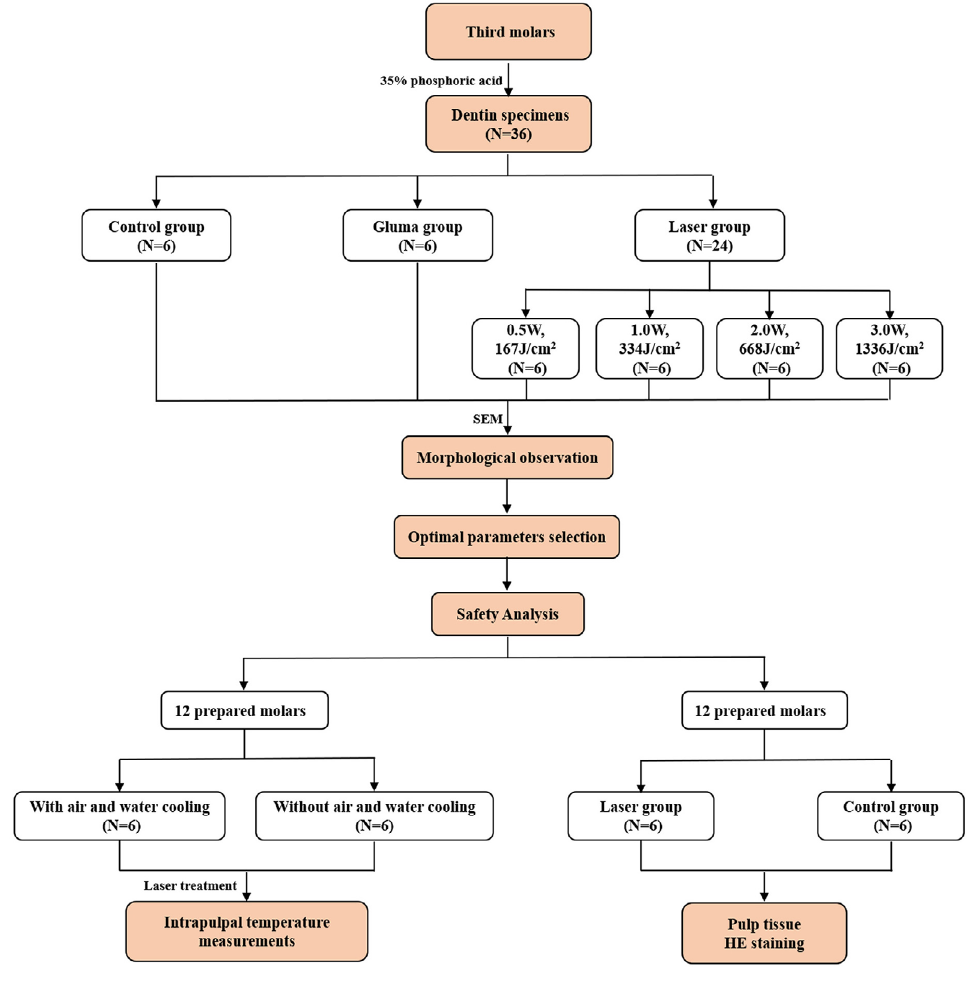
Figure 1- Flow diagram of the